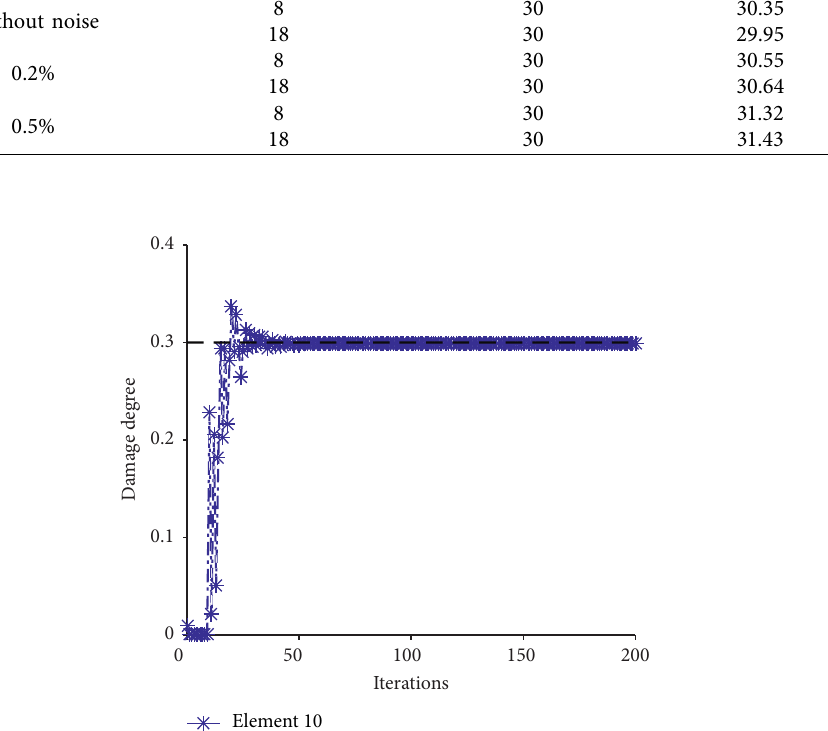
Figure 7: The reduction in stiffness calculated by IBAS (single damage case+0.5% for the noise